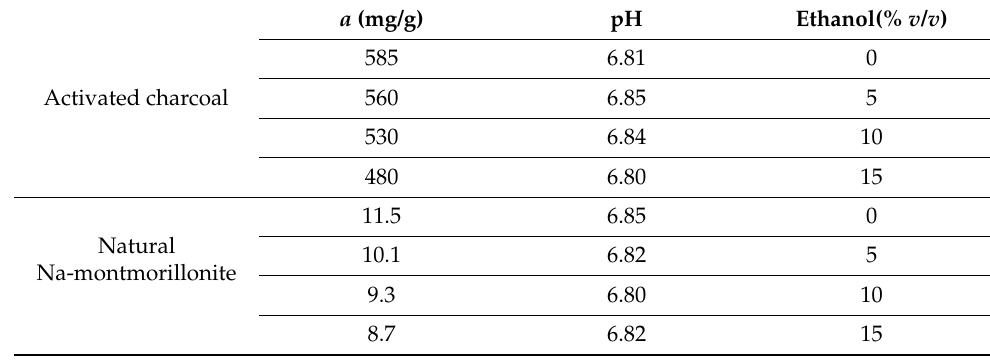
Activated charcoal Activated